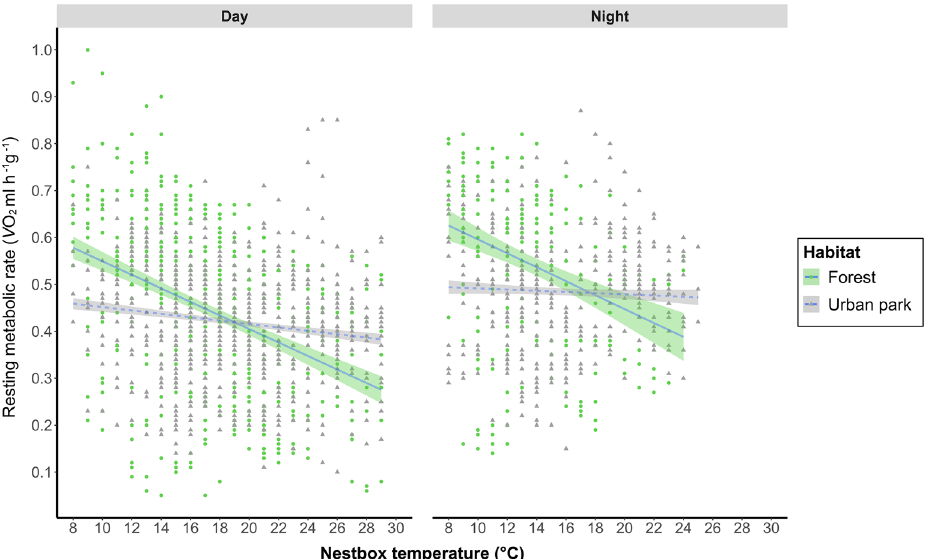
Figure 1. Fitted lines of model predictions and 95% CI band generated from the top ranked model as well as data points for diurnal (left panel) and nocturnal (right panel) mass specific resting metabolic rate ( V O 2 ml h −1 g −1 ) at measured ambient temperatures (diurnal range 8–29 °C, nocturnal range 8–25 °C) for forest (solid line, green band and green dots, N = 7) versus urban (dashed line, grey band and grey triangles, N = 13) squirrels (see Supplementary Figure S5 for graphs per